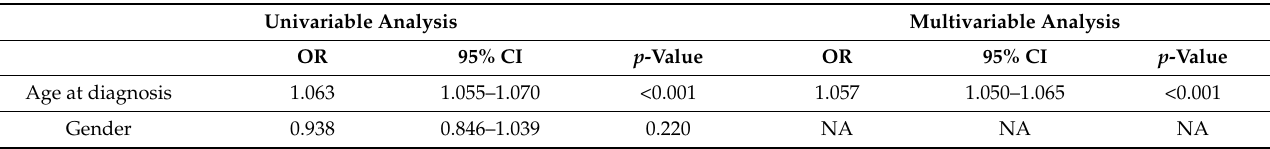
Table 3. Uni- and multivariate A logistic regression model for the association between positive FOBTs and diagnosis of colorectal